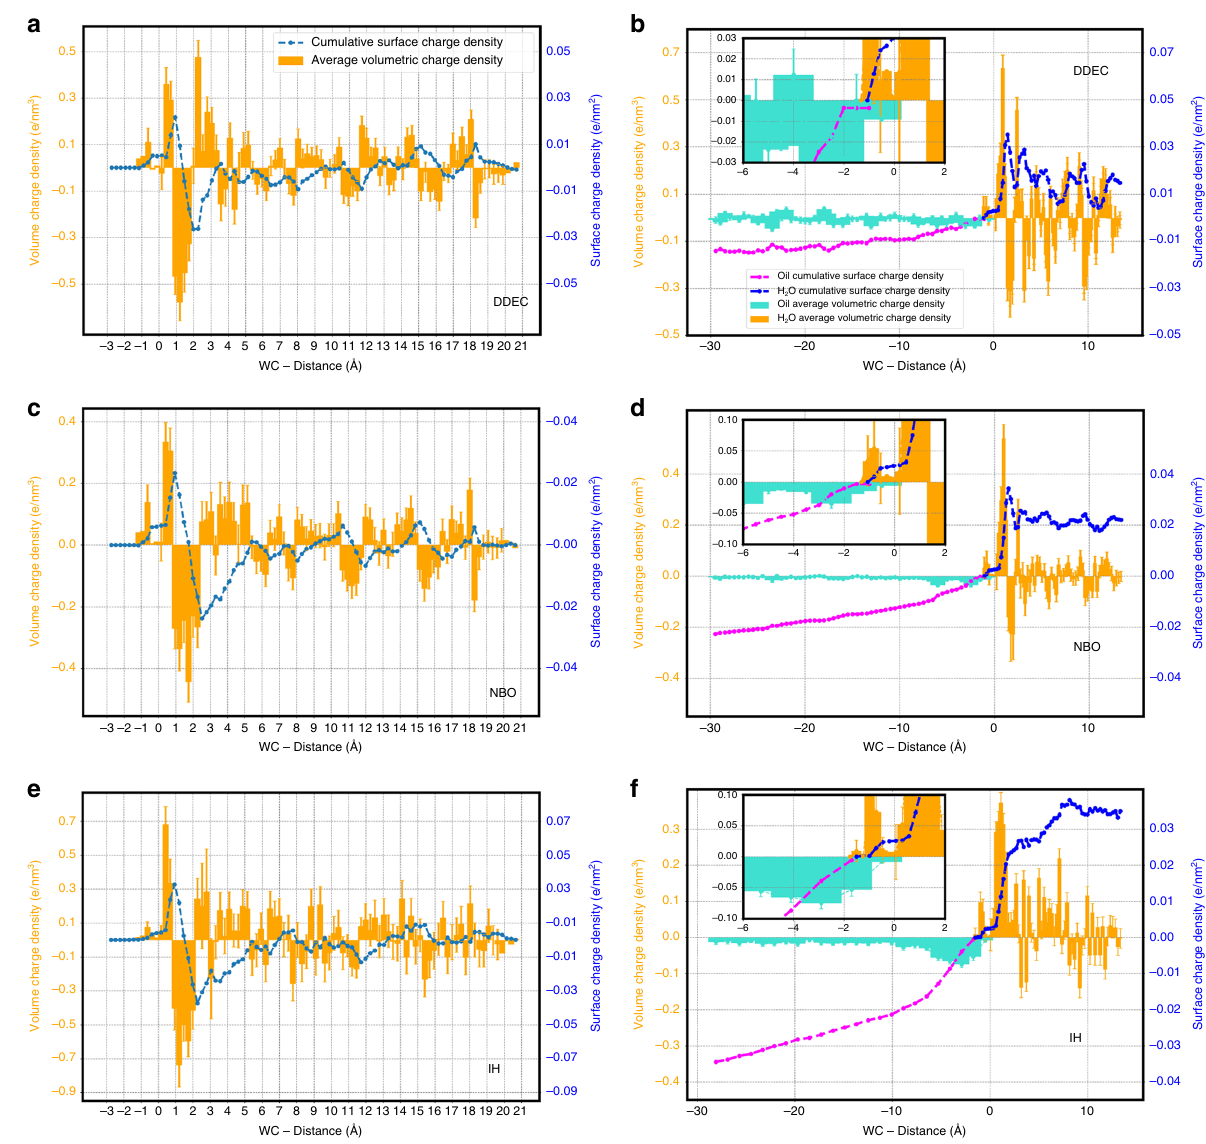
Fig. 8 Charge scheme validation. Comparison of the charge pro fi les obtained for 20 test frames using IH, NBO, and DDEC charge schemes for both water/ air ( a , c and e ) and water/oil ( b , d and f ) interfaces. The same colors and axis scales from Fig. 2 were used here. The error bars represnt the standard deviations calculated from the single frames charge densities with respect to the average